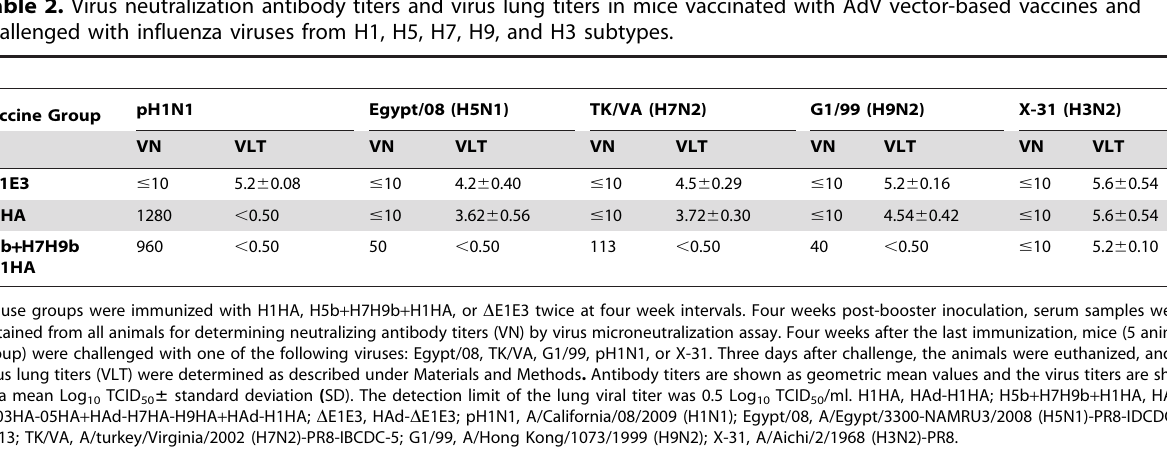
Table 2. Virus neutralization antibody titers and virus lung titers in mice vaccinated with AdV vector-based vaccines and challenged with influenza viruses from H1, H5, H7, H9, and H3 subtypes.